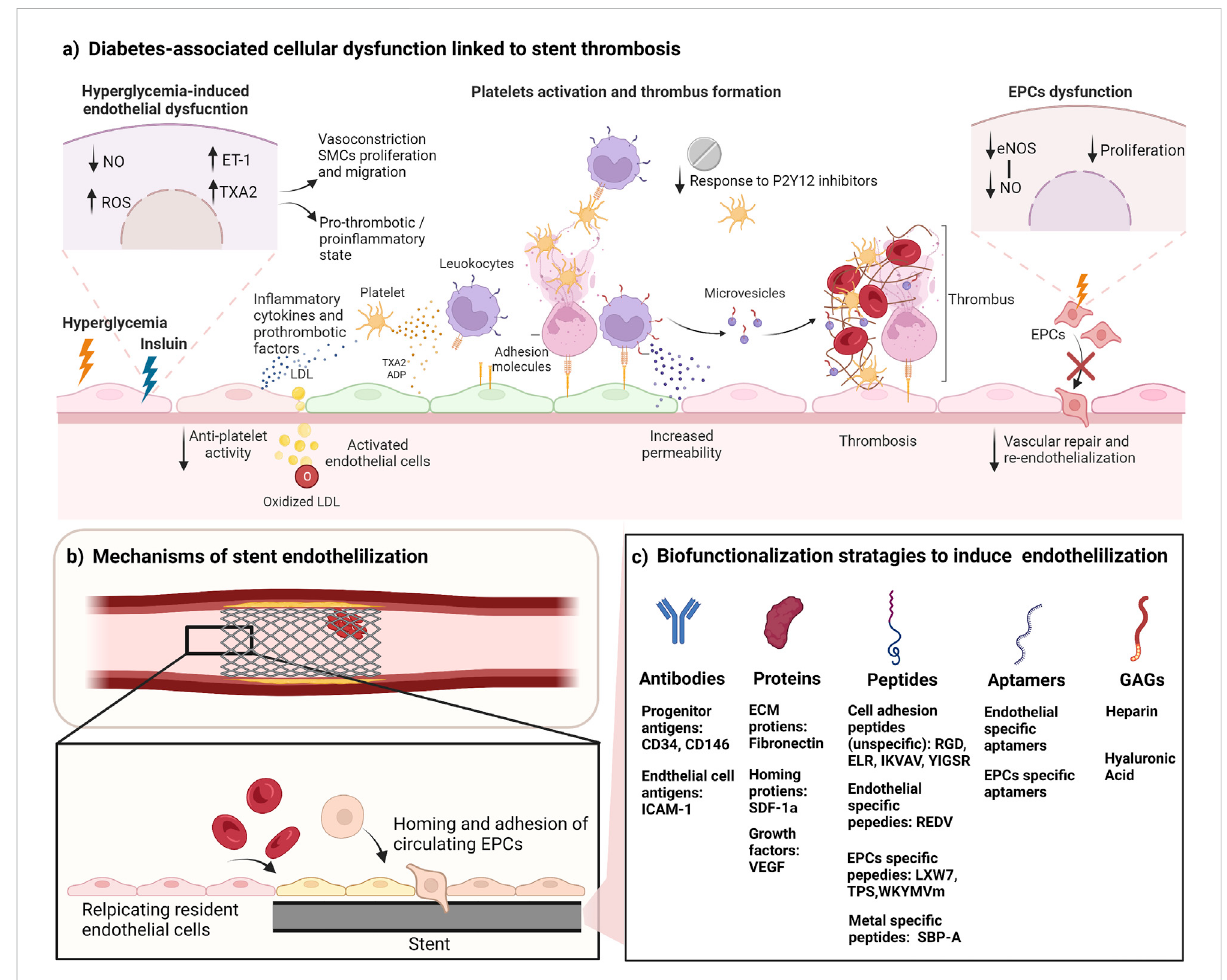
FIGURE 1 Biofunctionalization of stents to improve endothelialization and reduce thrombosis. (A) Cellular dysfunction in diabetes leads to high risk of stent thrombosis. Hyperglycemia results in vascular dysfunction characterized by reduced generation of NO, and induced synthesis of ET-1 and TXA2, resulting in a proin fl ammatory, pro-thrombotic and vasoconstrictive state. In addition, the chronic activation of endothelial cells by insulin affects the production of vasoprotective and antithrombotic factors. Diabetes also causes platelet hyperactivity, and hypo-responsiveness to anti-platelets drugs. Activated platelets bind to the vascular endothelium directly through adhesion molecules and stimulate an in fl ammatory response. Platelets also deposit chemokines into the surface of endothelial cells leading to leukocyte recruitment, and platelets can bind to leukocytes that adhere to theendotheliallayer.Plateletsalso canin fl uenceendothelial cells bytheirsecretionofvasoactive molecules(such as ADP, serotoninandTXA2)fromtheirgranules.TheregenerativemechanismsbyEPCsarealsoimpairedduetoEPCsdysfunctioncharacterizedbyreduced EPC proliferation, and impaired eNOS and NO production. (B) Endothelialization of stents can reduce stent thrombosis. Stent endothelialization happens through 2 mechanisms: resident cell replication and EPC recruitment. Both mechanisms are impaired in diabetes. Targeting these mechanisms can enhance the endothelialization rate. (C) Biofunctionalization strategies to promote stent endothelialization. Surface biofunctionalization with mimicry factors aims to induce EPCs mobilization, capture, adhesion, and proliferation. Some of the listed factors also induce the proliferation of resident endothelial cells. NO, nitric oxide; eNOS, endothelial nitric oxide synthase; ROS, reactive oxygen species; TAX2, thromboxane A2; ET-1, endothelin-1; ADP, Adenosine diphosphate; LDL, low density lipoprotein; SMCs, smooth muscle cells; EPCs,